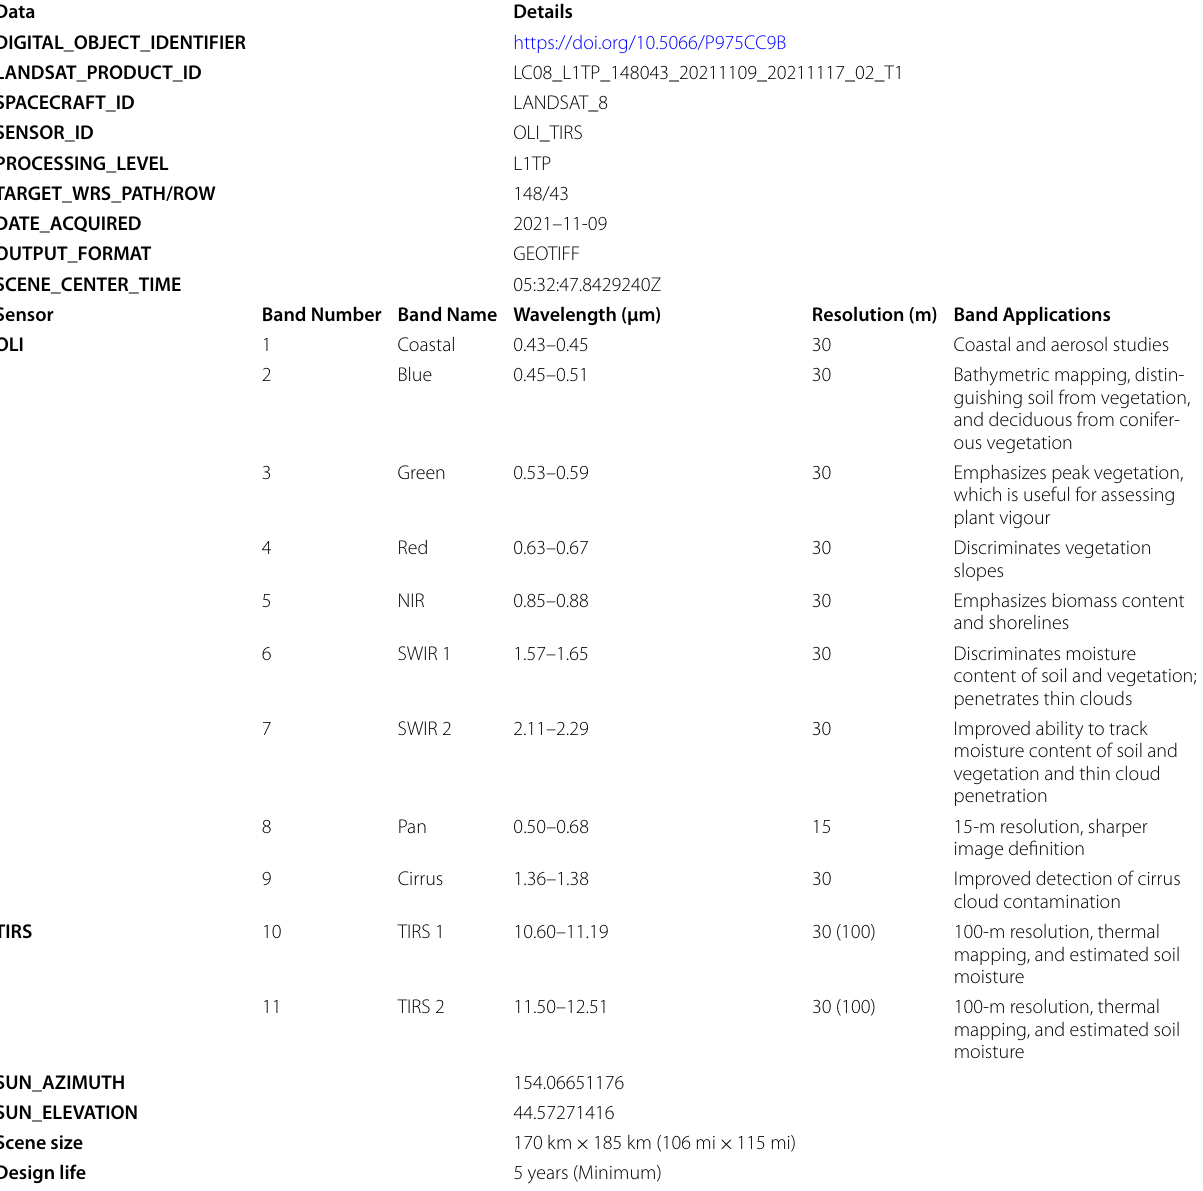
Table 3 Metafile details of Landsat 8 dataset Data